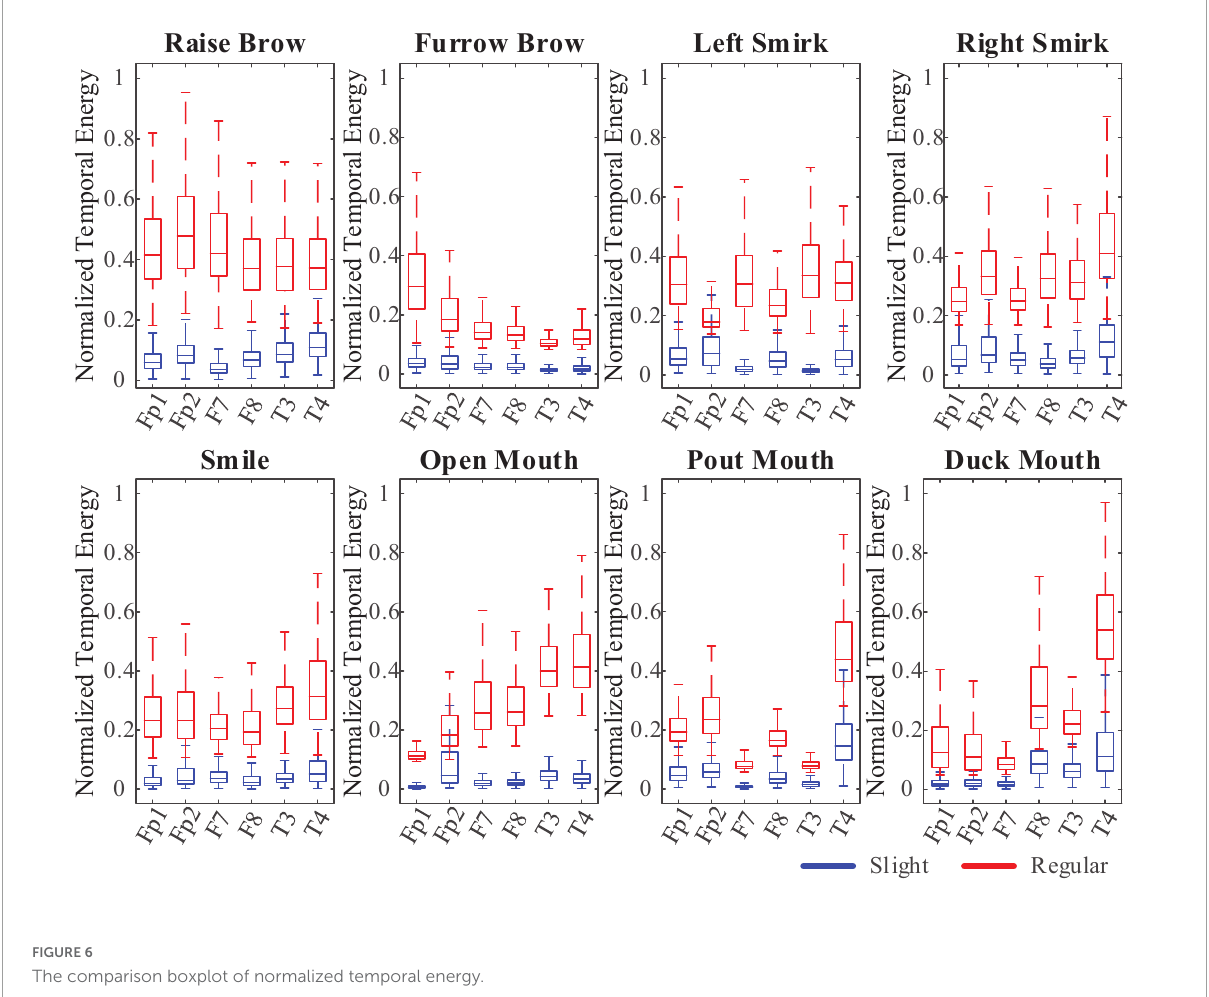
FIGURE6 The comparison boxplot of normalized temporal energy.